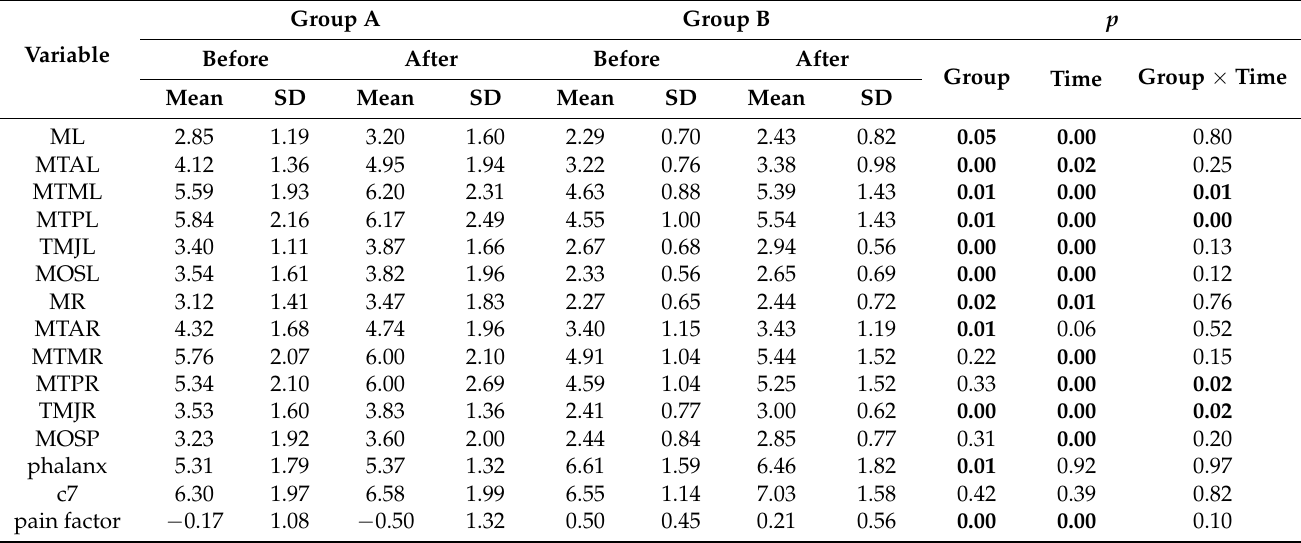
Table 1. Results of algometric measurements among the subjects. Significant p values are highlighted in bold. Group A Group B p Variable Before After